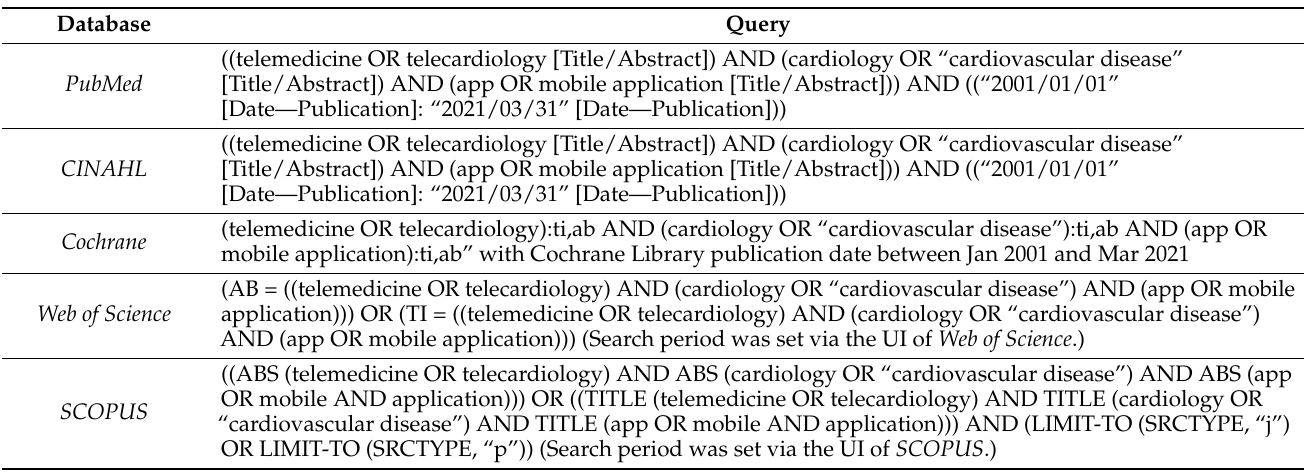
Table 1. Our search queries as we executed them per database. Database